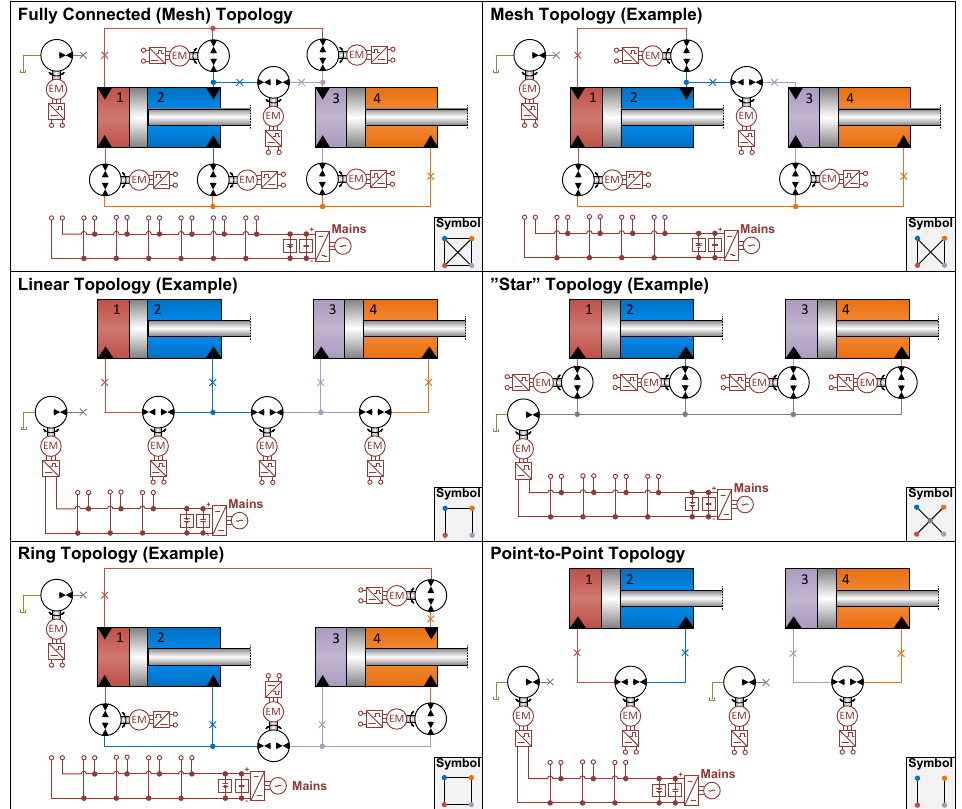
Figure 3. Basic electro-hydraulic variable-speed drive network topologies for a dual cylinder